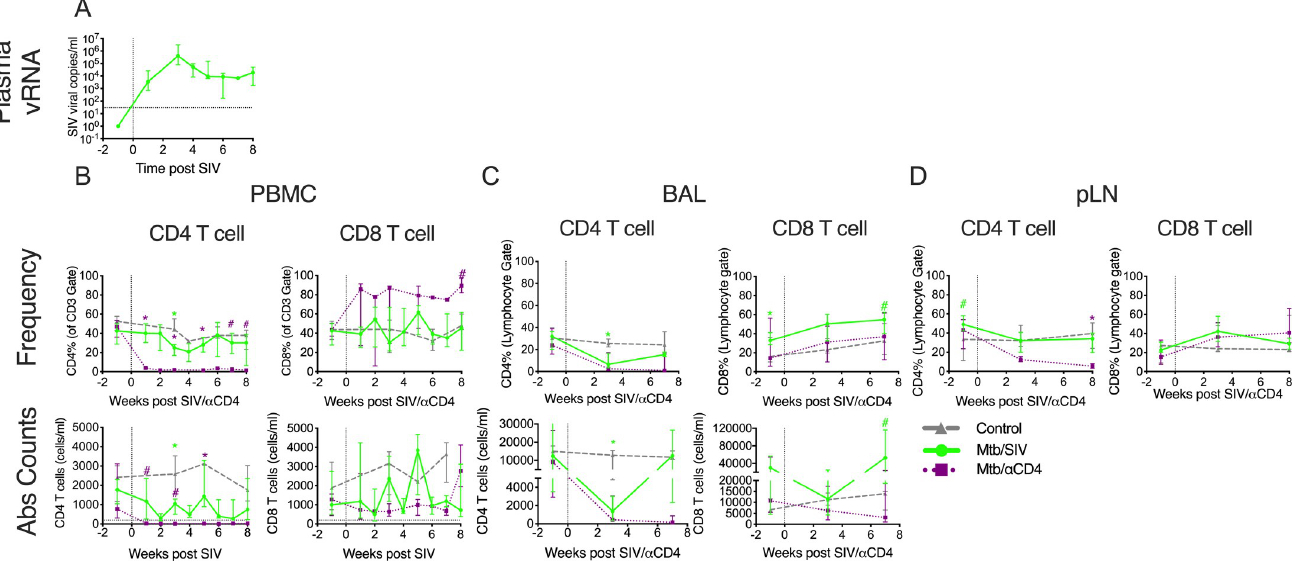
Fig 1. Changes in plasma viral RNA copies and T cells in peripheral blood mononuclear cells (PBMC), bronchoalveolar lavage (BAL), and peripheral lymph node (pLN) over time. A) Plasma viral RNA copies (reported as mean and standard deviation) among Mtb/SIV co-infected animals are shown. B) Peripheral CD4 T cells within Mtb α /CD4 animals are more severely reduced compared to Mtb/SIV co-infected animals with latent infection. C) Total absolute CD4 and CD8 T cell counts and frequencies were measured in BAL cells. D) CD4 and CD8 T cell frequencies were measured in pLN. Changes in absolute CD4 and CD8 T cell counts (Abs Counts) and frequencies after SIV mac251 infection (green line, Mtb/SIV, n = 8), α CD4 depletion antibody (purple line, Mtb/ α CD4, n = 7) and controls (grey line, Mtb-only control, n = 6) are shown. Statistics reported are Steel tests comparing Mtb/SIV and Mtb/ α CD4 at each time point (adjusted for comparing Mtb-only controls to Mtb/SIV [green stats marker] and Mtb/ α CD4 to Mtb/SIV [purple stats marker]). For B-D, medians are shown with error bars representing interquartile range. � p < 0.05, # p < 0.10.